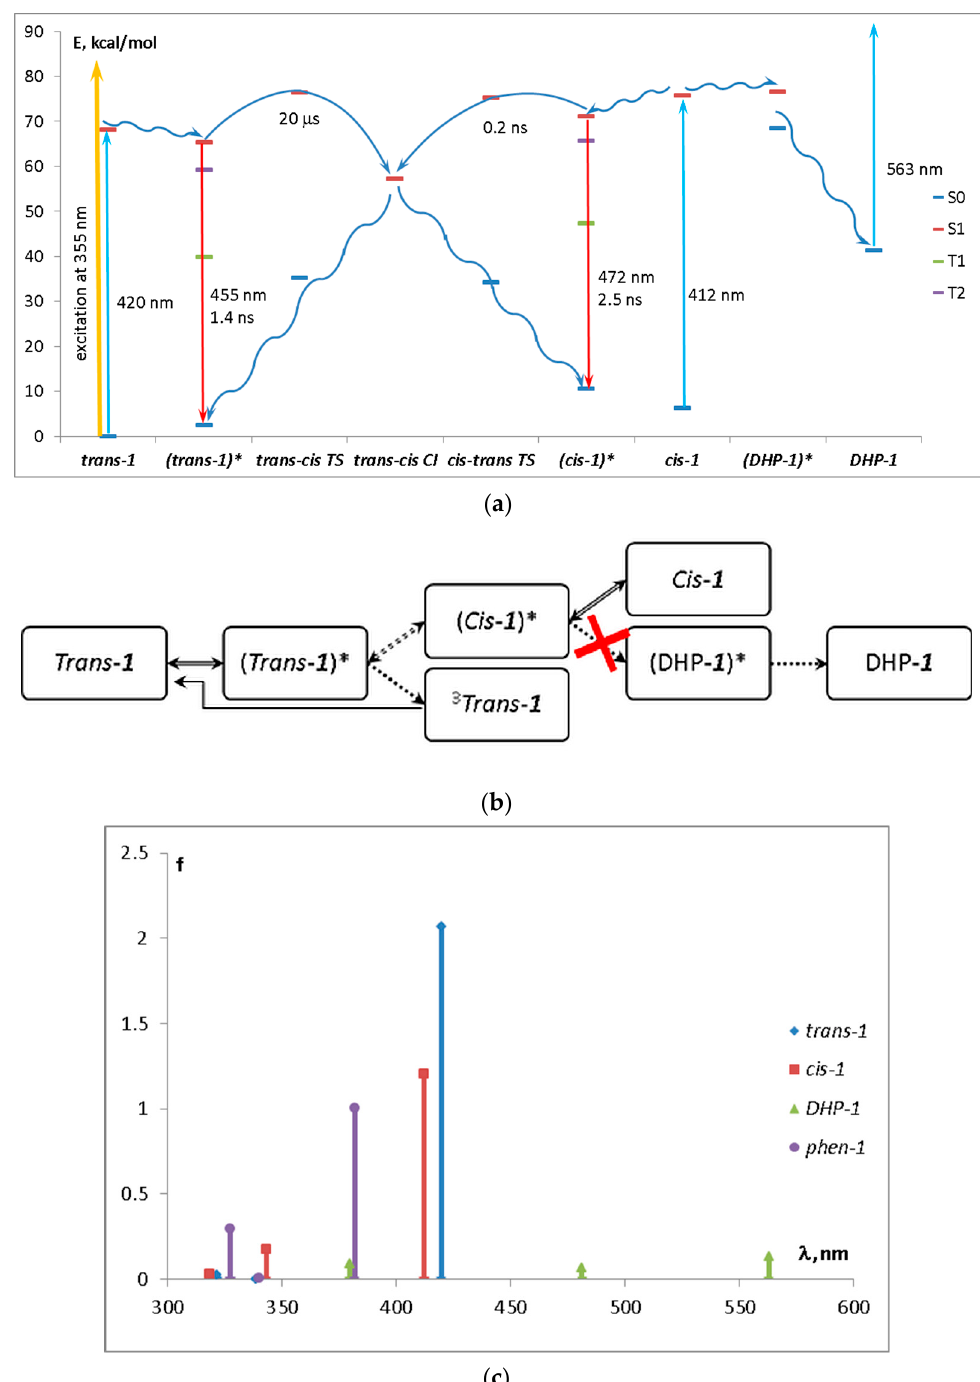
Figure 10. ( a ) Energy level diagram of diazadistyryl benzene 1 , ( b ) scheme of its possible phototransformations, and ( c ) absorption maxima of the phototransformation products. Straight arrows on the energy diagram denote radiative processes, and wavy arrows denote nonradiative processes.